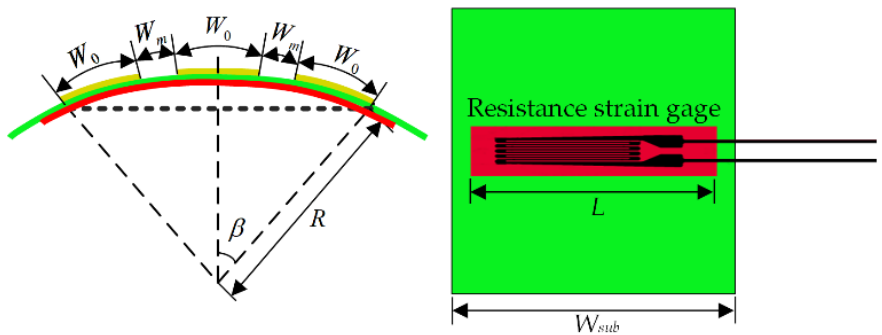
Figure 14. Bending deformation of the reconfigurable antenna element.